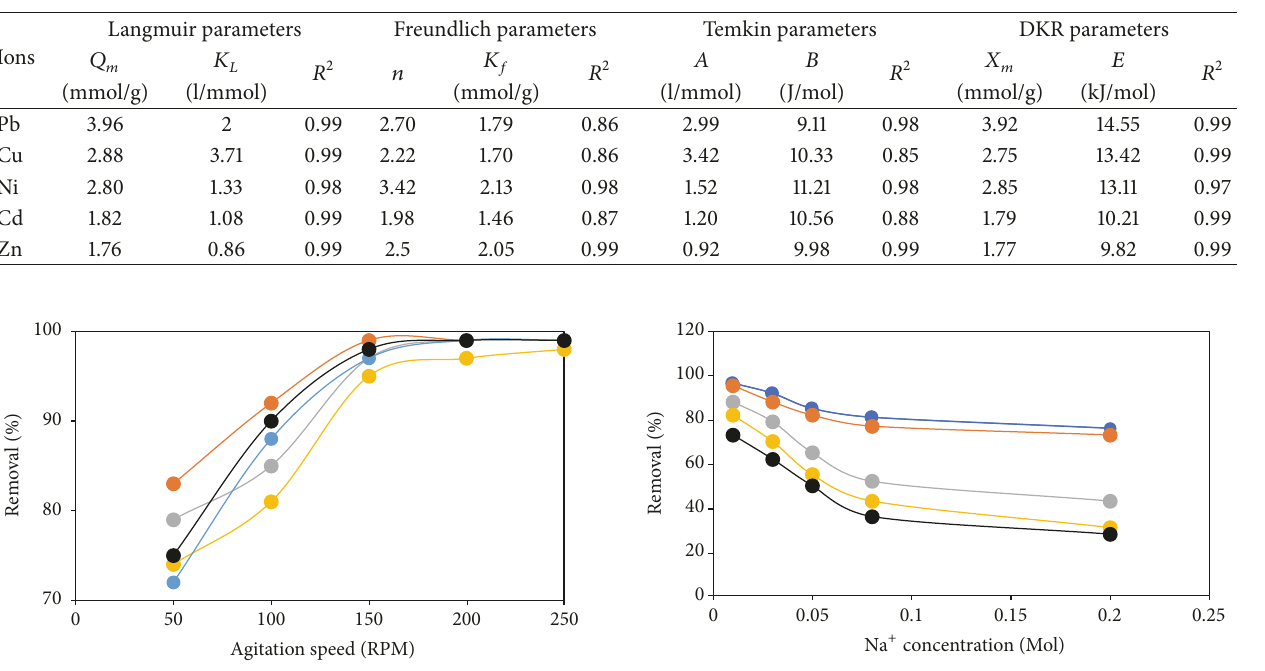
Table 1: Langmuir, Freundlich, Temkin, and DKR isotherm parameters for binding of considered metal ions onto FGCX at temperature of 45 ∘ C.